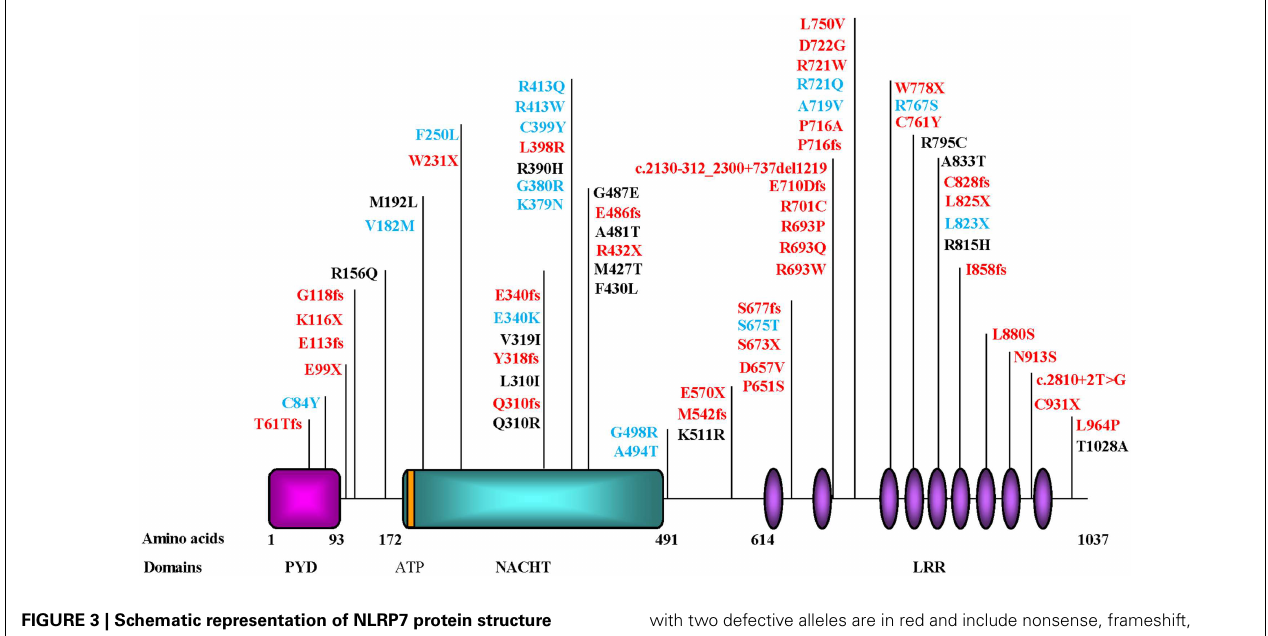
FIGURE 3 | Schematic representation of NLRP7 protein structure and identified mutations and variants in patients with hydatidiform moles and reproductive loss . PYD, stands for the pyrin domain, NACHT, stands for found in the NAIP, CIITA, HET-E, andTP1 family proteins; ATP for adenosine 5 (cid:48) -triphosphate binding motif; and LRR, for leucine rich repeats.The ATP binding domain is a small motif of 8 amino acids and starts at position 178. Mutations found in patients